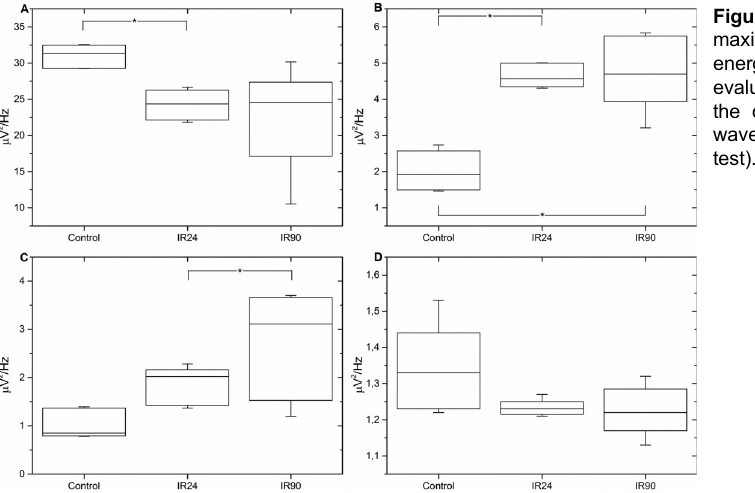
Figure 4. Box plot (median, 1st and 3rd quartiles, maximum and minimum) showing the results of the energy values for the groups control, irradiation evaluated at 24 h (IR24) and at 90 days (IR90) for the delta ( A ), theta ( B ), alpha ( C ) and beta ( D ) waves. *P o 0.05 (Kruskal-Wallis nonparametric